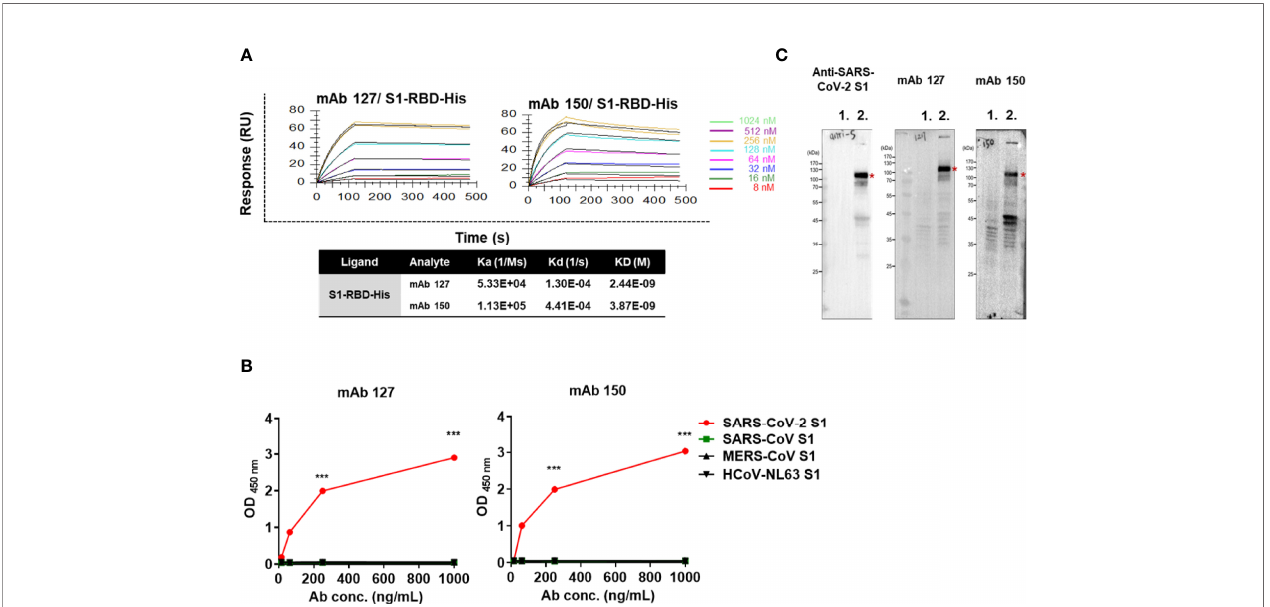
FIGURE 3 | The mAbs 127 and 150 speci fi cally bind to SARS-CoV-2 S1-RBD. (A) Af fi nity of mAbs 127 and 150 for S1-RBD. The S1-RBD-His-bound sensors were incubated with the different concentrations of mAbs 127 or 150 (indicated by different colors) for a set time interval to allow association. The sensors were then moved to protein-free solution and allowed to dissociate over a time interval. The binding kinetics were determined using Biacore T200 Evaluation Software version 3 with 1:1 binding model fi tting. (B) The binding ability of mAbs 127 and 150 to SARS-CoV-2 S1, SARS-CoV S1, MERS-CoV S1 or HCoV-NL63 (1 m g/ mL) was analyzed by indirect ELISA. (C) Cell lysates of mock-infected or SARS-CoV-2 NTU13-infected Vero-E6 cells (MOI=0.1, 24 h post-infection) were separated by SDS – PAGE under reducing condition and stained with 1 m g/mL commercial anti-SARS-CoV-2 S1 mAb or mAb 127 or 150 as indicated and visualized by Western blotting. Lane 1: lysates of mock-infected Vero-E6 cells; lane 2: lysates of NTU13-infected Vero-E6 cells. The asterisks indicate the SARS- CoV-2 S1 subunit of the S protein, which has a predicted MW of approximately 120 kDa. All statistical data are presented as the means± S.Ds. from at least two independent experiments. ***P<